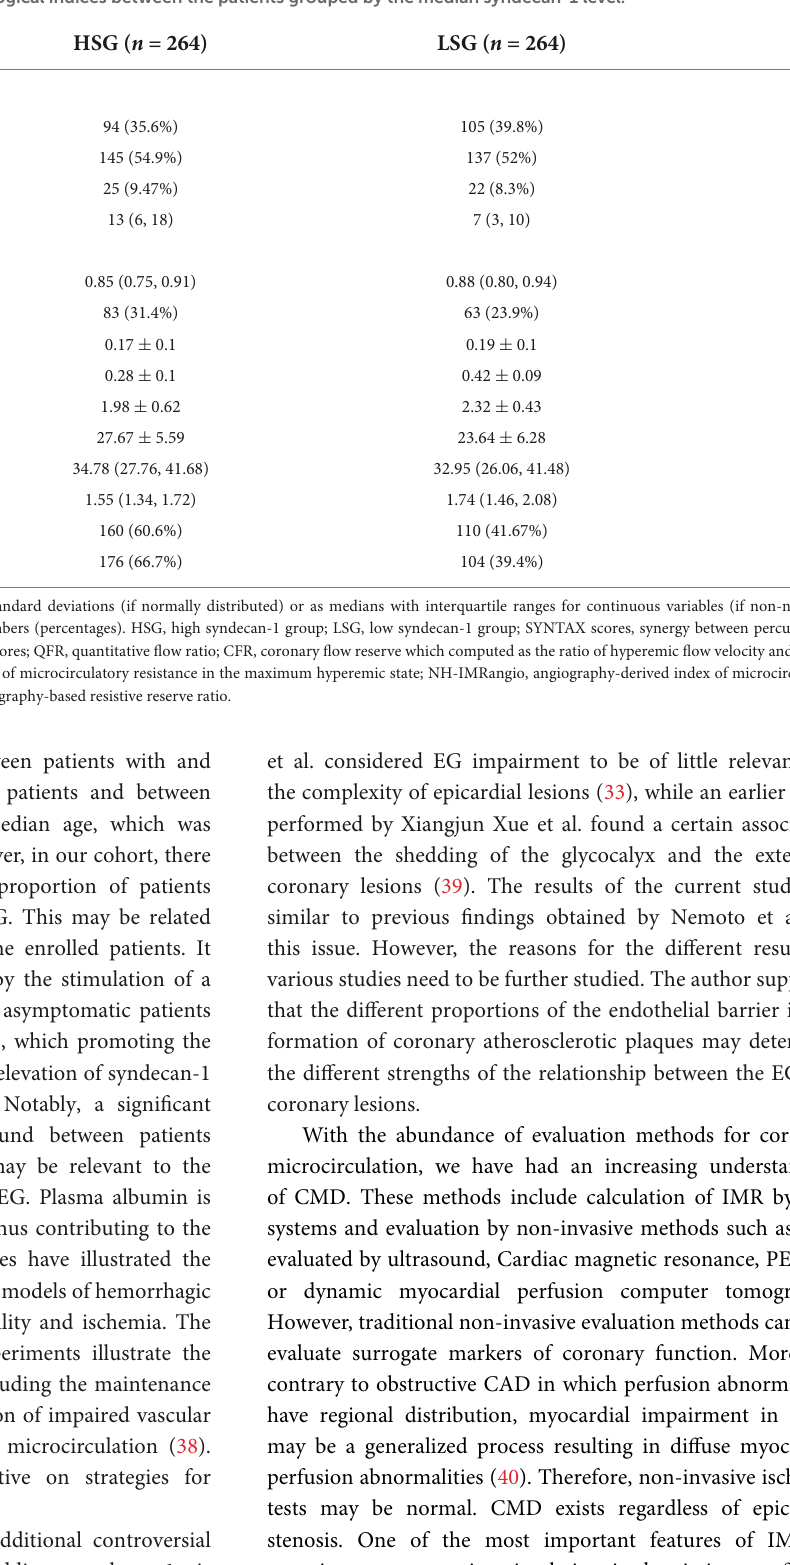
TABLE 2 Angiographic findings and physiological indices between the patients grouped by the median syndecan-1